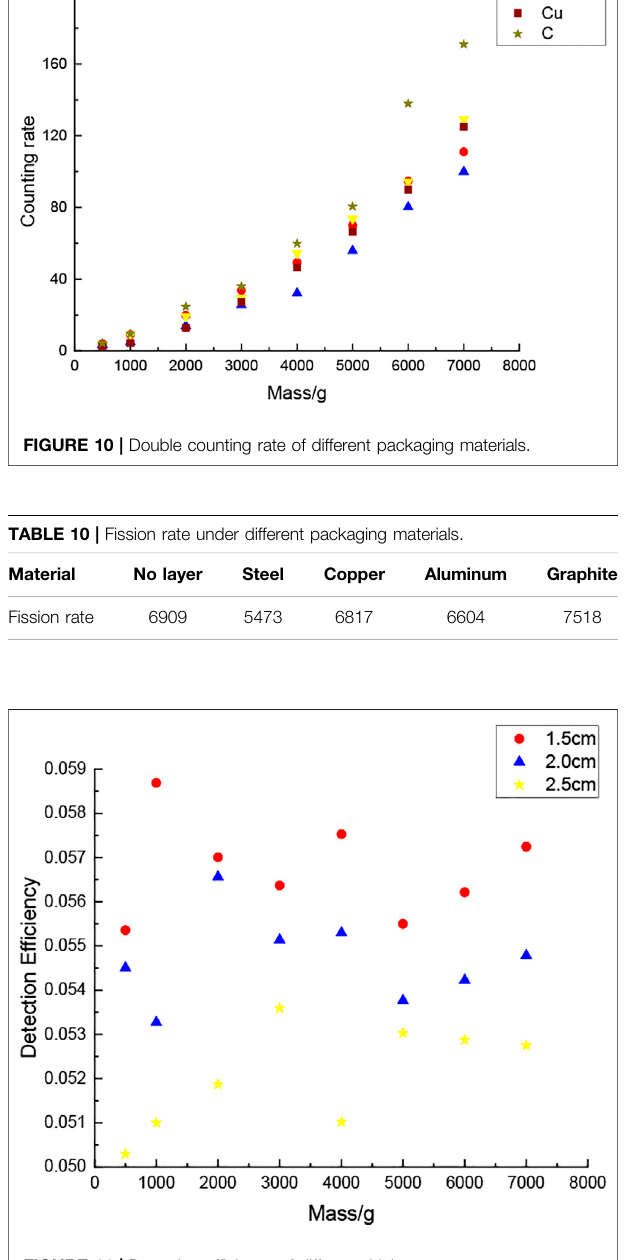
FIGURE 11 | Detection ef fi ciency of different thicknesses.